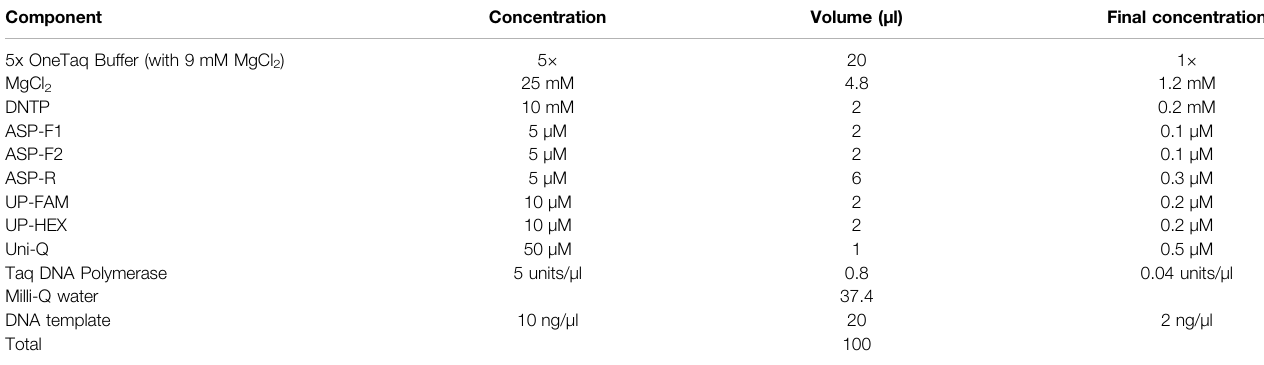
TABLE 1 | PCR cocktail mix composition for the proposed ASQ method of SNP genotyping.